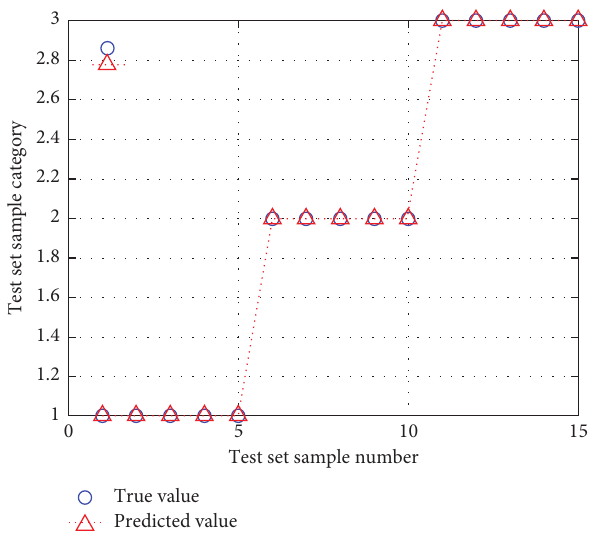
Figure 4: Experimental results of cheese products based on probabilistic neural network algorithm. (1, brand XX; 2, brand YY; and 3, brand ZZ).